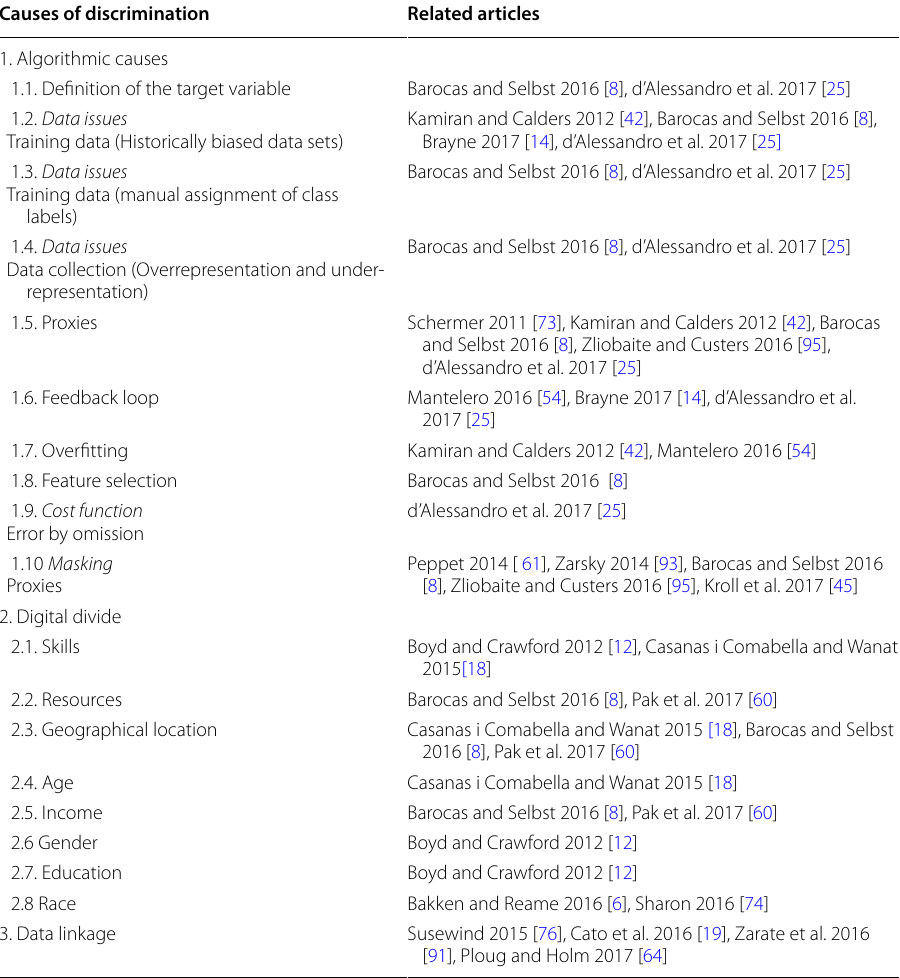
Table 4 Causes of discrimination in data analytics Causes of discrimination Related